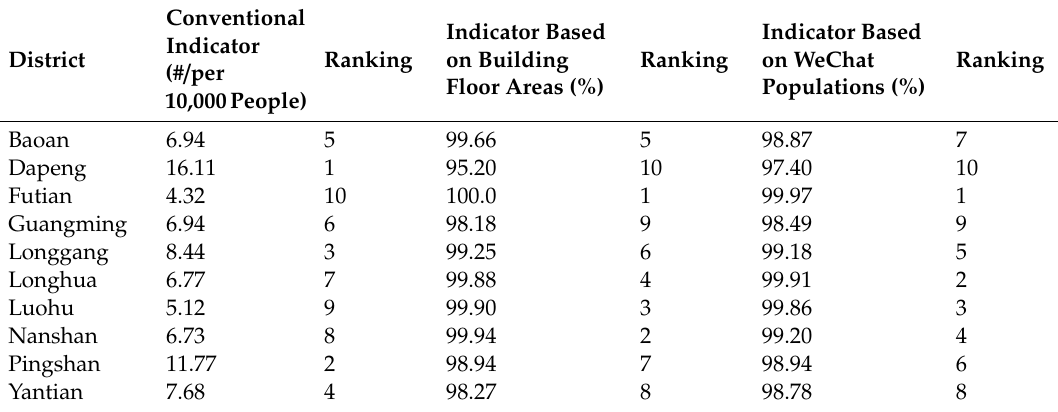
Table 3. Rankings of districts by the indicator of transportation.